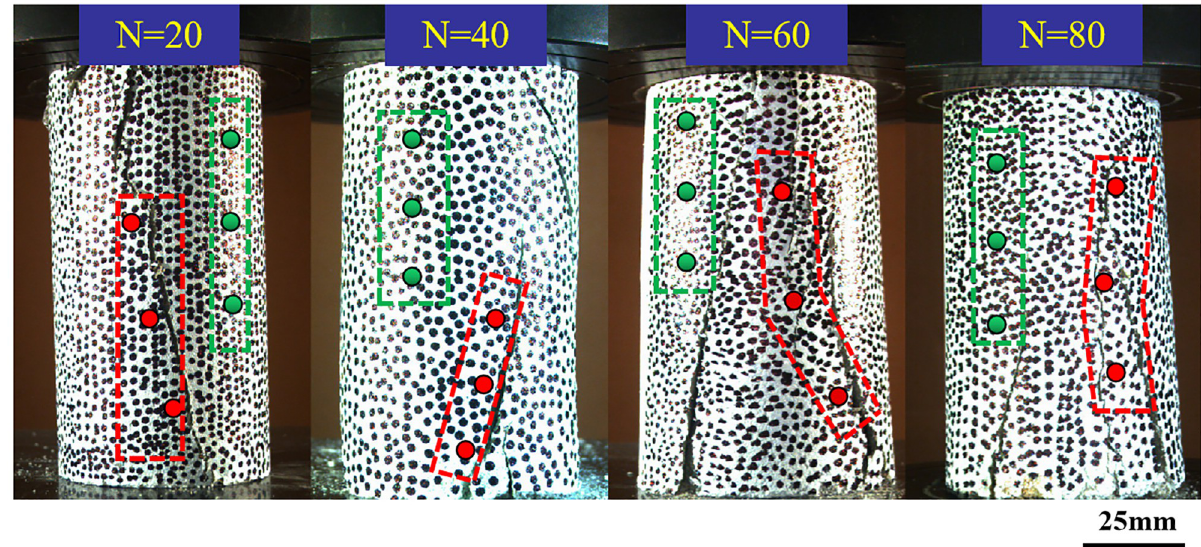
Fig 6. Location of monitoring points in the cracked zone and the non-cracked zone.